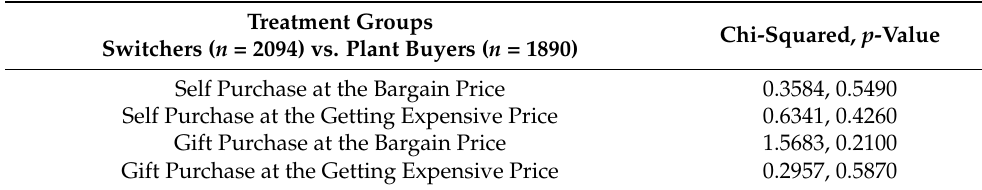
Table 4. Comparison of the proportion of subjects as switchers and plant buyers in each of the four treatment